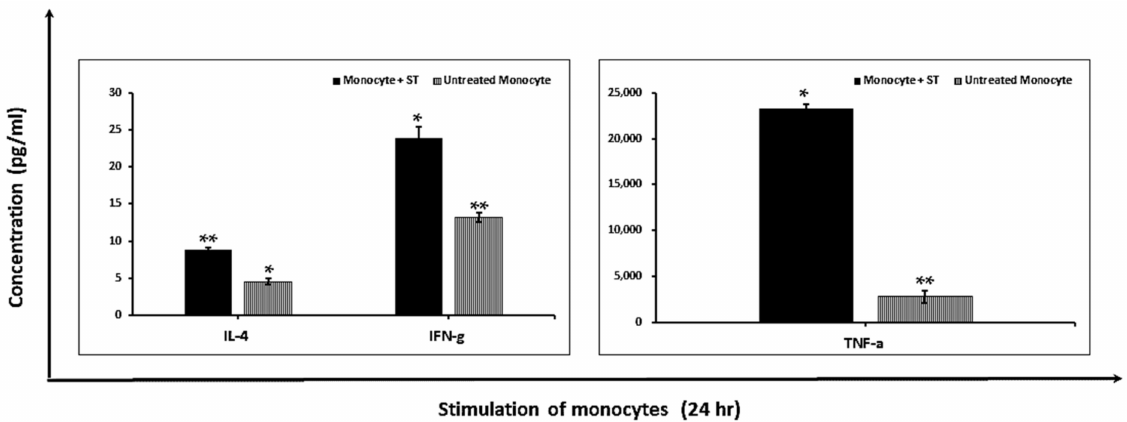
Figure 5. ST285 increases anti-inflammatory cytokine production by human monocytes. Human monocytes ( n = 3) were stimulated with ST285 for 24 h and secretion of IL-4, IFN- γ , and TNF- α were measured. The treated human monocytes ( n = 3) with ST285 probiotic bacteria are referred to as monocyte + ST and human monocytes ( n = 3) cultured in media without any ST285 probiotic bacteria are referred to as untreated monocytes. The means of two different readings of three replicate experiments were measured and analyzed. The means of readings for n = 3 monocytes were calculated and presented as plus or minus ( ± ) the standard error of the mean. The symbols represent the p -value for Tukey’s test (one-way ANOVA) where * p < 0.05 and ** p <